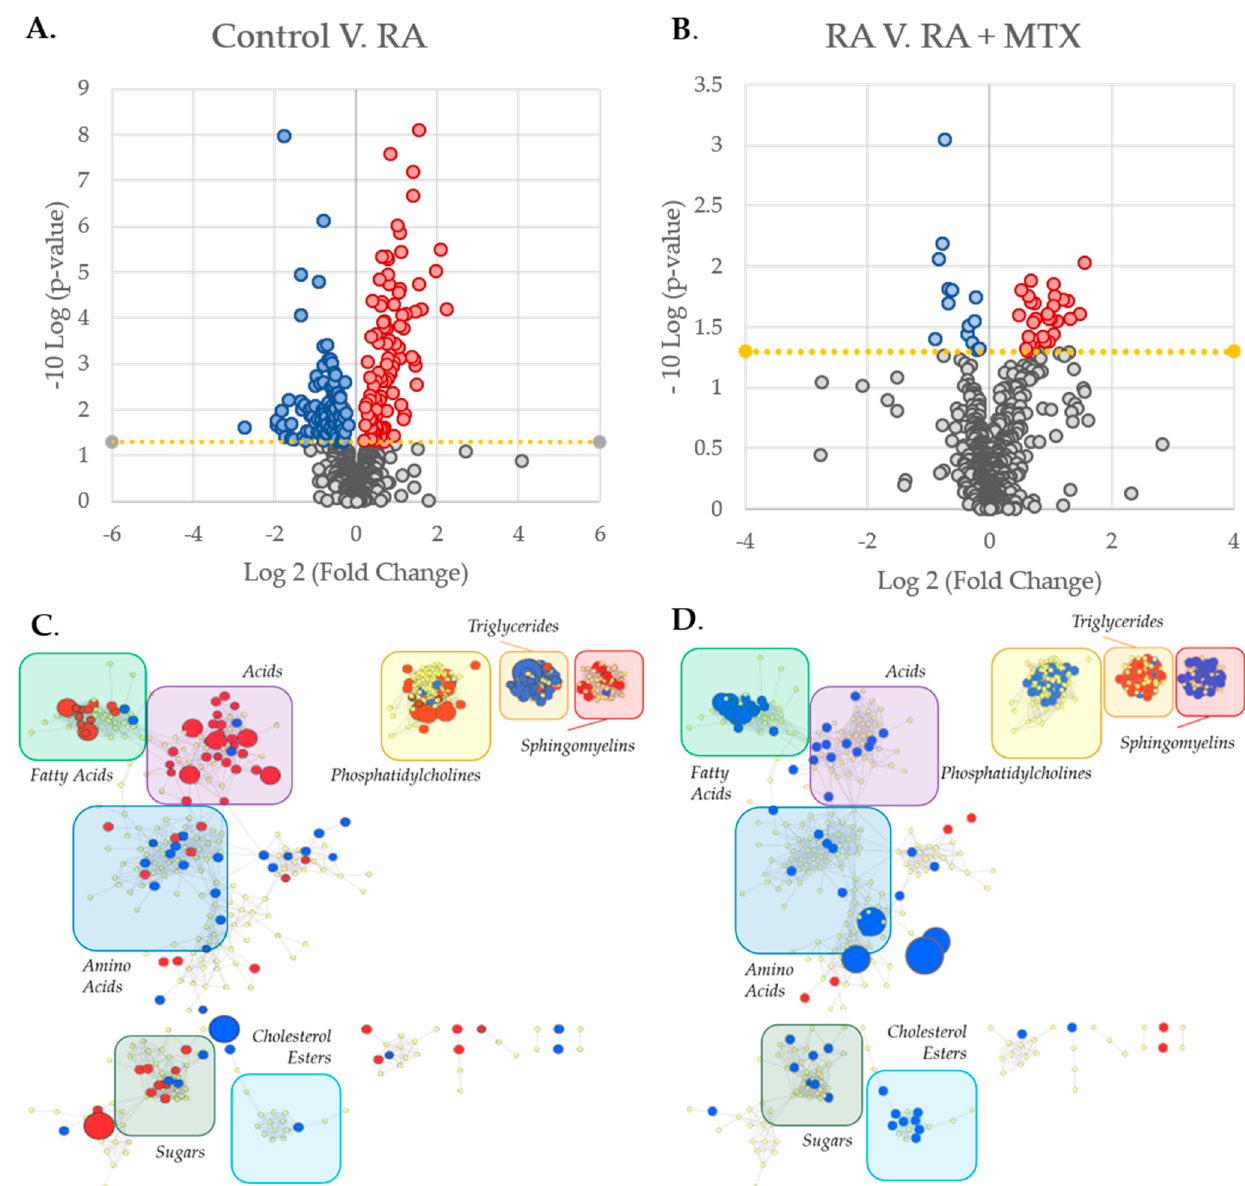
Figure 2. Identification and metabolic network mapping of key metabolites associated with RA and MTX therapy. Metabolomics data were analyzed with MetaboAnalyst 5.0 resulting in volcano plots for: ( A ) Healthy control subjects as compared with RA patients at baseline; ( B ) RA patients at baseline as compared with 16 weeks following the initiation of MTX. The metabolic network maps were built using MetaMapp 2020 and visualized using Cytoscape 3.7.2 providing maps of: ( C ) Healthy control subjects as compared with RA patients at baseline; ( D ) RA patients at baseline as compared with 16 weeks after the initiation of MTX. The metabolomic networks were divided into clusters using the community cluster tool and labeled by metabolic class. Red denotes metabolites found to be increased and blue denotes metabolites found to be decreased ( p < 0.05). Node size is directly proportional to the measured fold change.